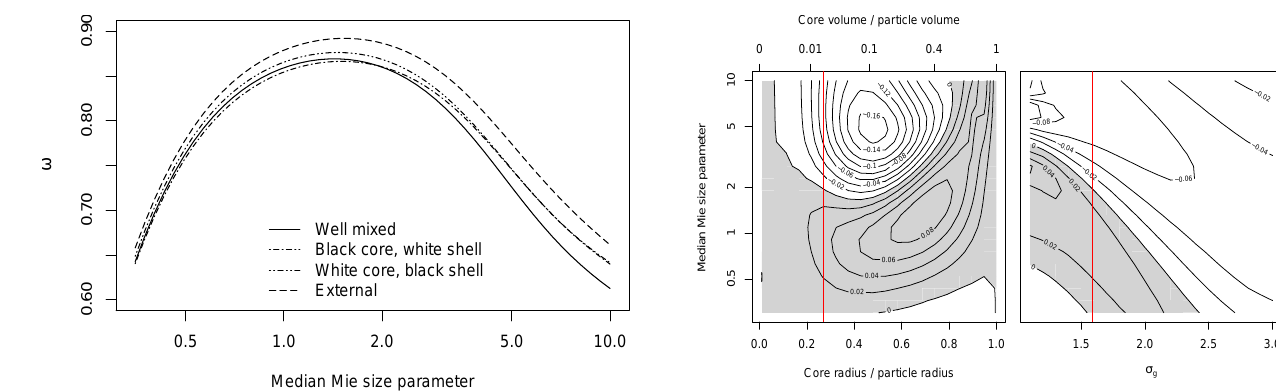
Figure 3. Single-scattering albedo of a mixture of 2% strongly ab- sorbing matter with refractive index m = 1 . 75 + i 0 . 43 and 98% less absorbing material with m = 1 . 5 + i 0 . 02. The particle radius is dis- tributed according to a log-normal mode with geometric standard deviation σ g = 1 . 59. Over the entire median Mie size parameter range, the internal mixtures with well-mixed (volume average re- fractive index mixing rule) and core-shell particles absorb more effi- ciently than the external mixture. Depending on the median Mie size parameter x median , absorption by core-shell particles with a black core is more ( x median . 2) or less ( x median & 2) efficient than by well-mixed particles. For all mixing states, left and right of the max- imum, the single-scattering albedo is very sensitive to the median Mie size parameter. Black coated spheres yield values between the result for internal and external mixing.